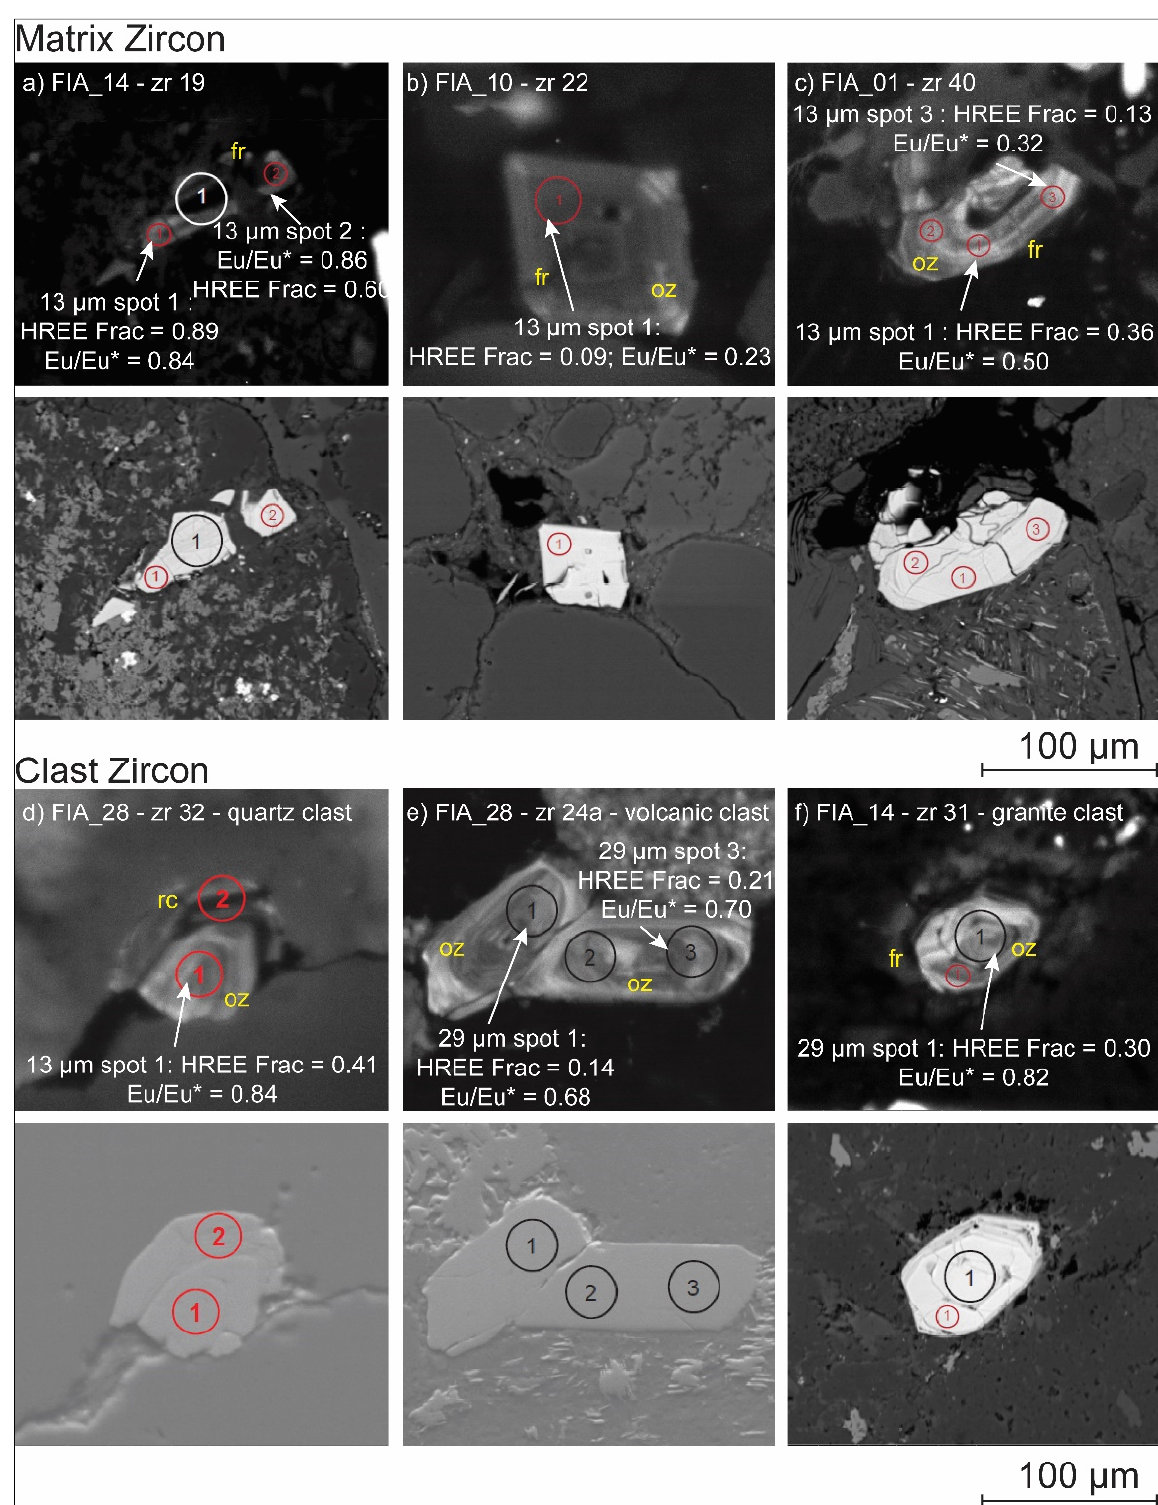
Figure 4. Representative cathodoluminescence (CL) and backscattered electron (BSE) images of zircon from basal diamictite samples used in this study. Representative zircon from the matrix ( a – c ) and quartz, volcanic, and granite clasts ( d – f ) are shown with locations of spot analyses (red circles = 13 μ m, black circles = 29 μ m) and HREE Frac content for each analysis. Geochemistry of spot locations are outlined in Figure 8c. Abbreviations used: oz: oscillatory zoning; fr: fractures; rc: recrystallisation.